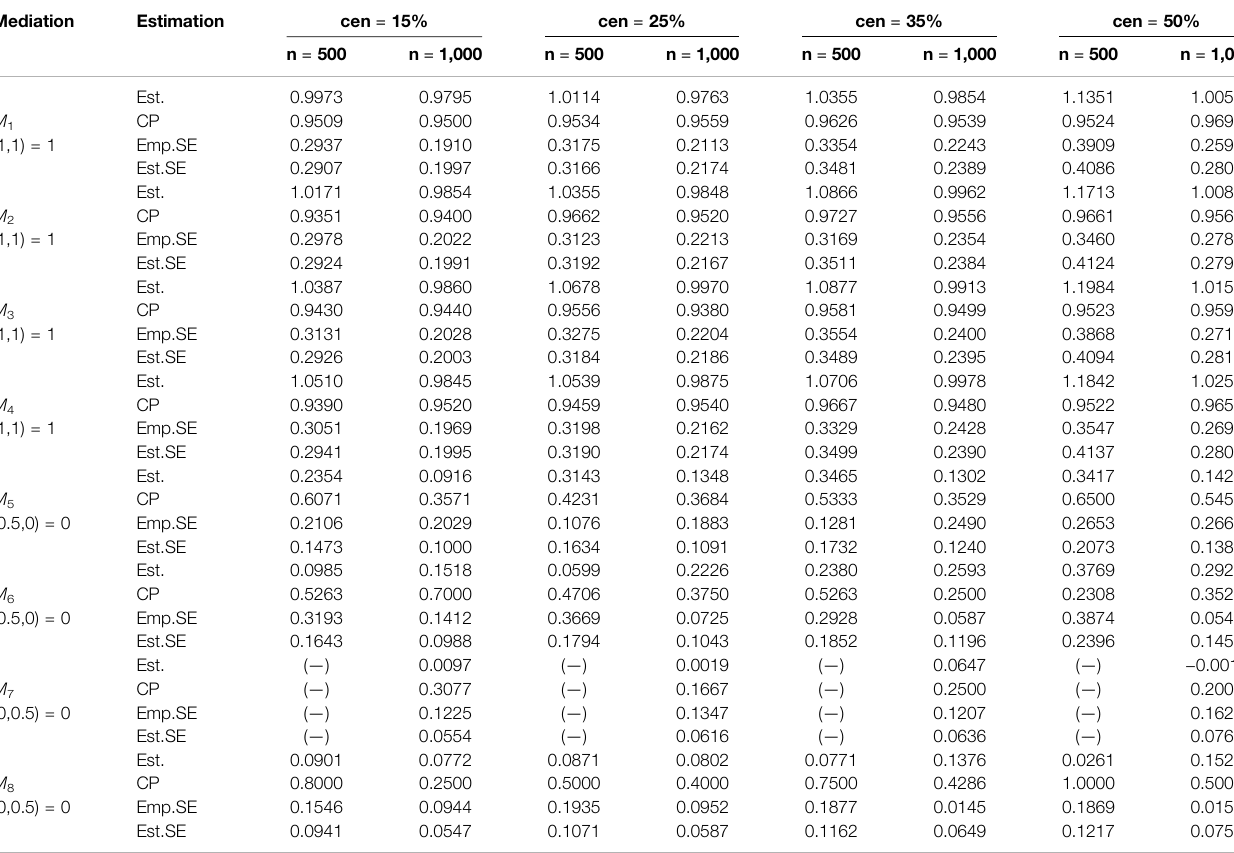
TABLE 2 | Indirect effect estimation of the proposed procedure. Mediation